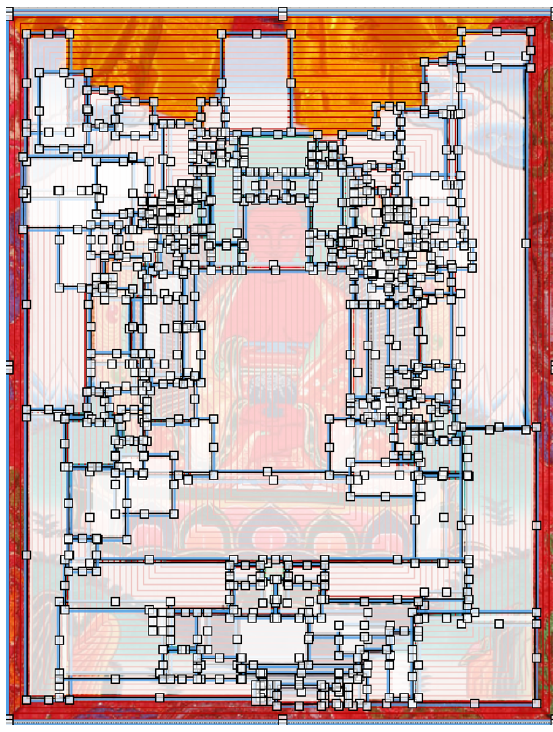
Figure 2. To create click-able regions that trigger the samples and returns RGB colour values, the image of Amitabha has been overlayed with transparent buttons and the Max object Suckha.